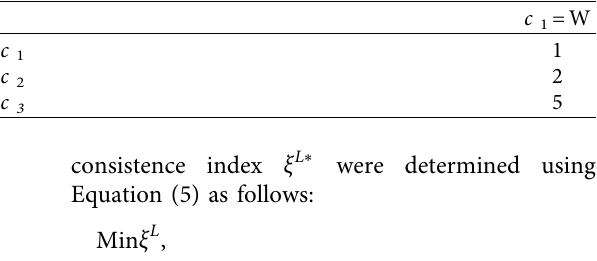
(Table 2). The normalized optimal weights of all attributes